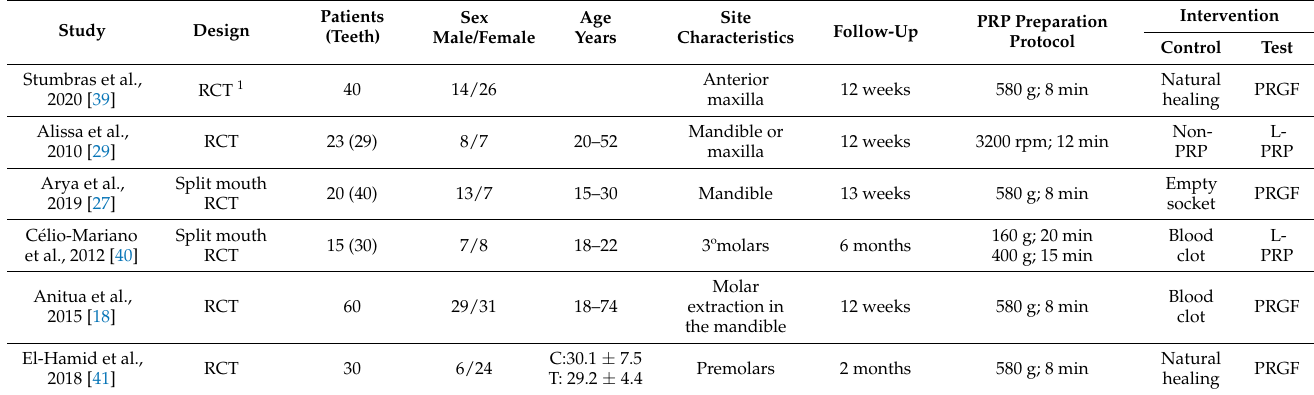
Table 1. Main characteristics of the included